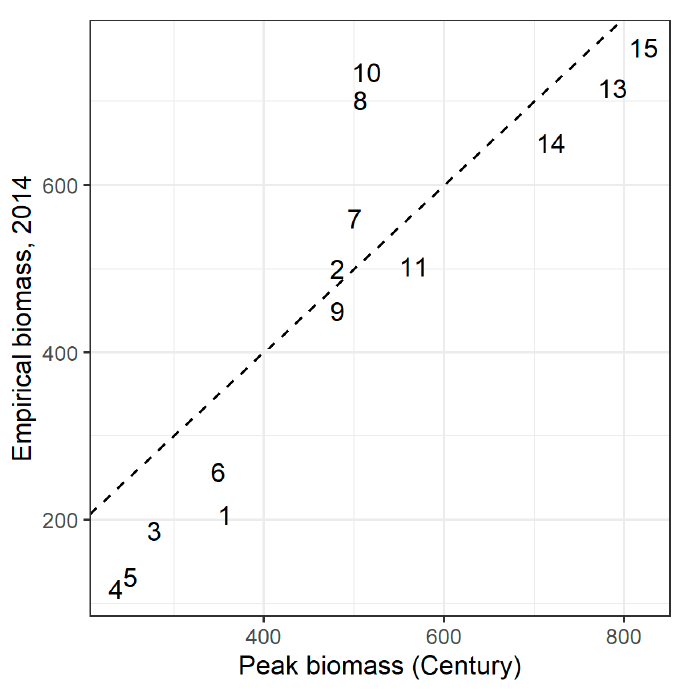
Figure A7. Peak annual biomass (kg/ha) at the site centroid predicted by Century, vs. empirical biomass sampled in 2014, after manual calibration. Dashed line shows 1:1 line. RMSE = 112.2